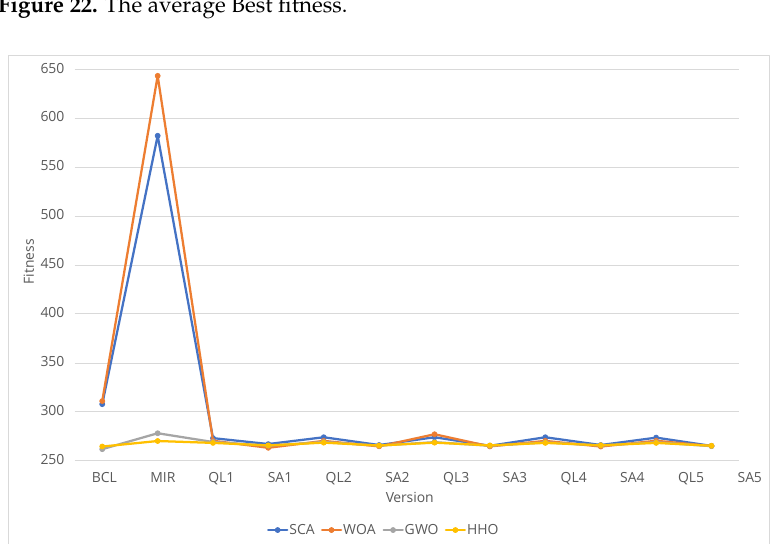
Figure 22. The average Best fitness.